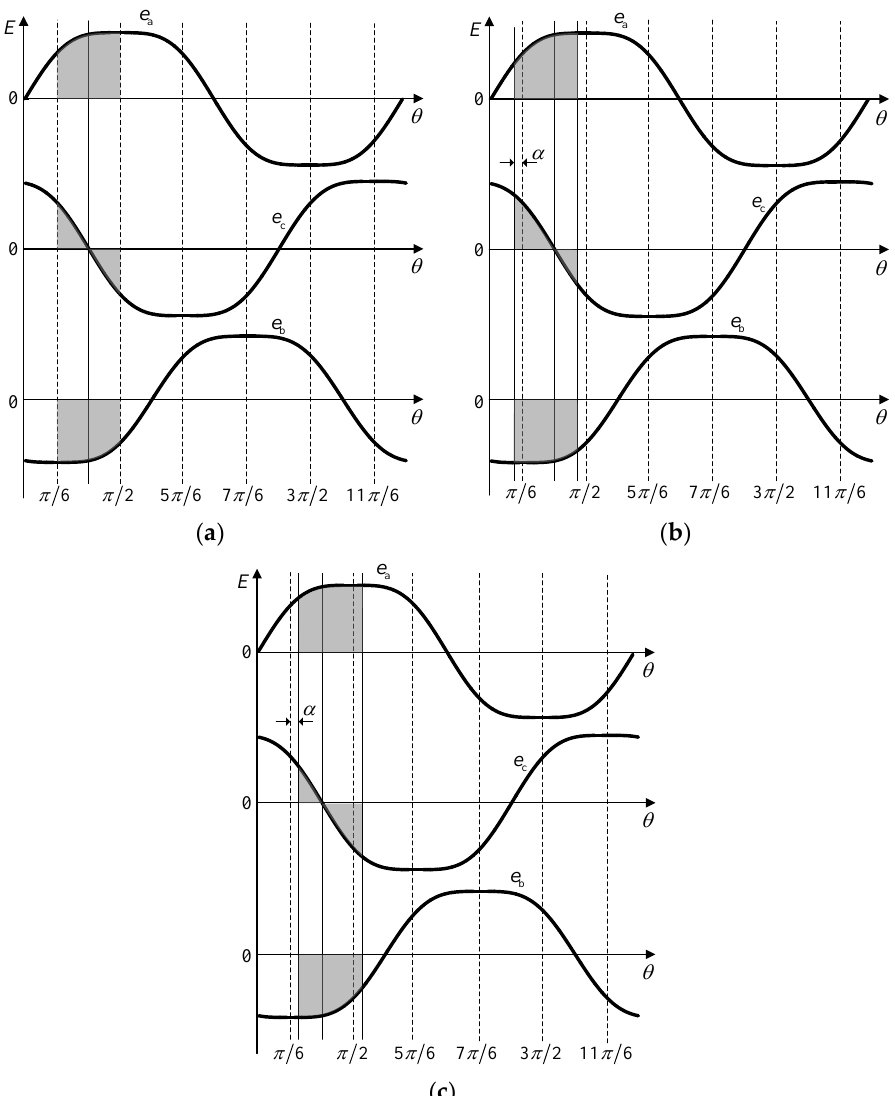
Figure 3. Three-phase back-EMF. ( a ) Accurate commutation; ( b ) Advanced commutation; ( c ) Delayed commutation.